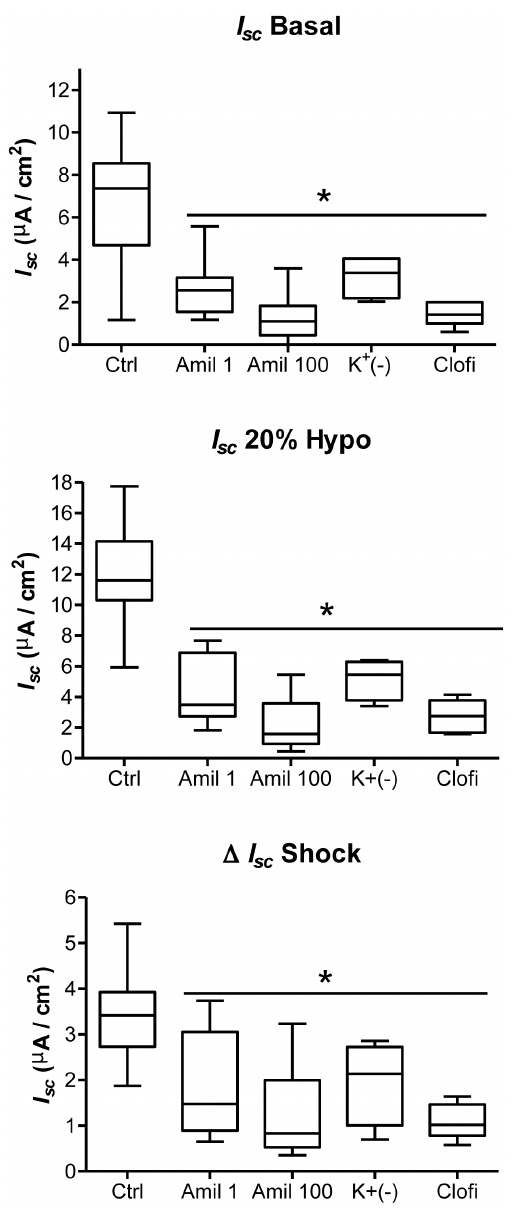
Figure 3. Role of Na + and K + currents in basal and hypotonic-induced transepithelial current. Basal transepithelial current ( I Basal), hypotonic-induced current ( I sc sc 20% Hypo) and the current rise elicited by hypotonic shock (Δ I Shock) are depicted in the basal condition (Ctrl), potassium- sc free condition (K + (-)) or after pretreatment with 1µM amiloride (Amil 1), 100 µM amiloride (Amil 100) or 100 µM basolateral clofilium (Clofi). In experiments where the cells were pre- treated with an inhibitor that impacted on I , hypotonic shock sc was induced when the current was stabilized. For amiloride the current was stable after 5 min. In potassium-free condition (K + (-)) and clofilium pre-treatment, a longer incubation was needed (~30 min). N≥4, *p<0.05 by Mann-Whitney Test compared to untreated